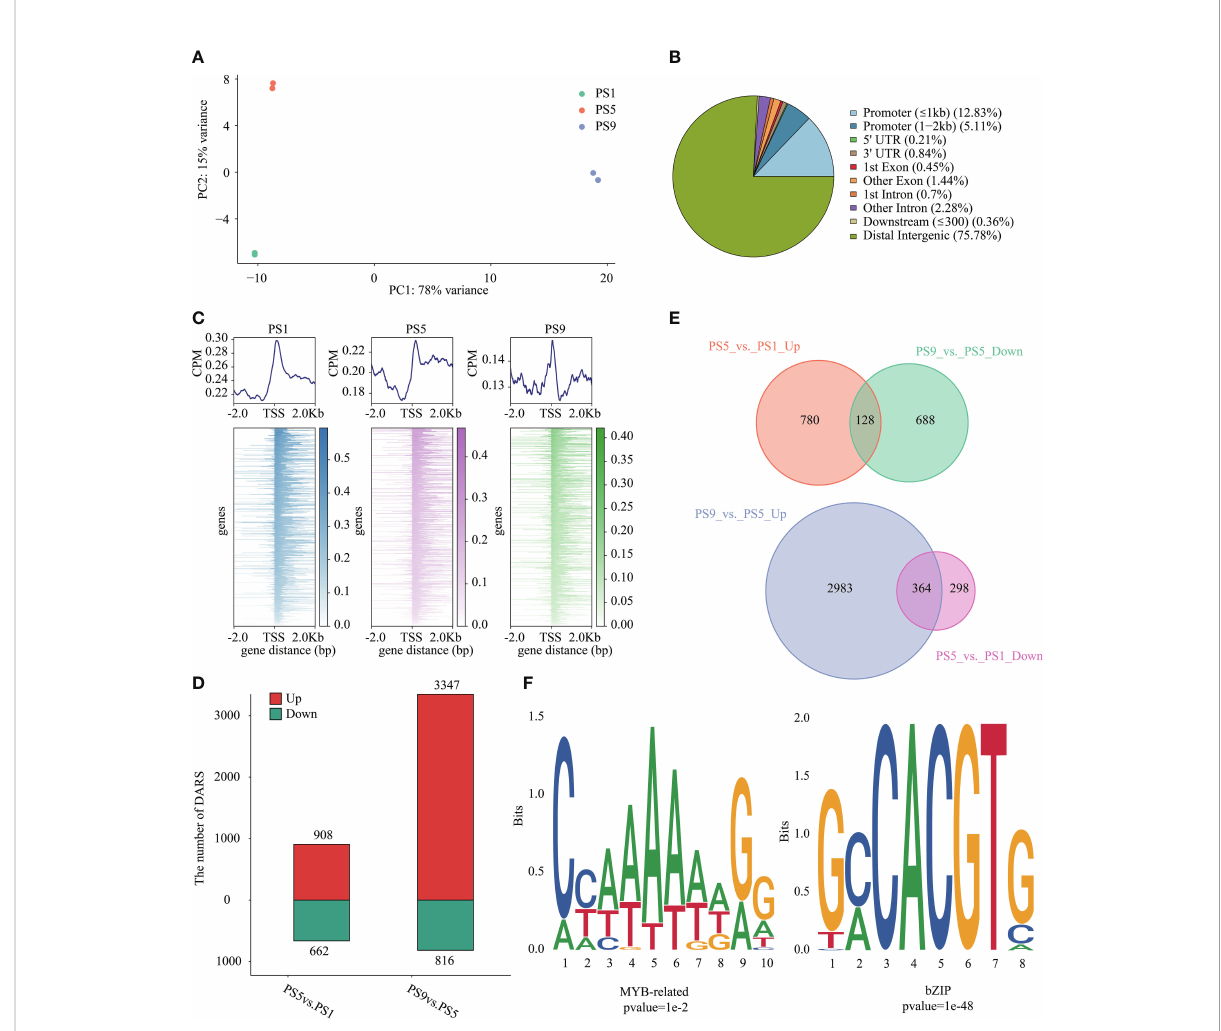
FIGURE 3 Chromatin accessibility features of red apple fruit during ripening. (A) PCA analysis result of red apple ATAC-Seq data at PS1, PS5 and PS9; (B) Relative location of the identi fi ed peaks in different gene regions; (C) Relative location of peaks to red apple genes in the upstream of 2 Kb and downstream of 2 Kb in the TSSs region; (D) Numbers of DARs in different comparisons; (E) Venn diagrams of DARs up-regulated in PS5_vs_PS1 but down-regulated in PS9_vs_PS5 (top) and DARs down-regulated in PS5_vs_PS1 but up-regulated in PS9_vs_PS5 (bottom); (F) Motif enrichment analysis results of MYB related motifs in DARs up-regulated in PS5_vs_PS1 but down-regulated in PS9_vs_PS5 and bZIP motifs in DARs up-regulated in PS9_vs_PS5 but down-regulated in